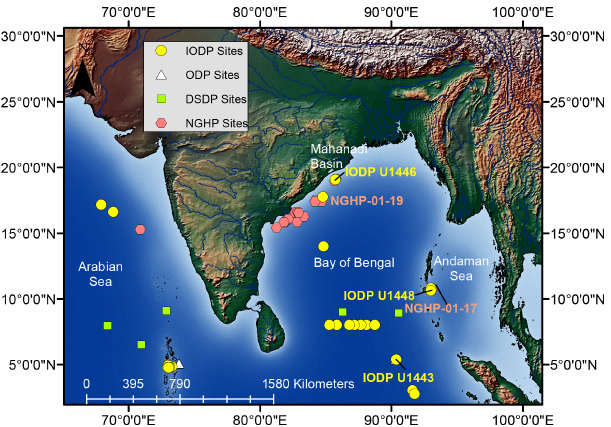
Figure 2. Location map including scientific drilling sites in the northern Indian Ocean. These include expeditions of the Interna- tional Ocean Discovery Program (IODP), Ocean Drilling Program (ODP), Deep Sea Drilling Project (DSDP), and Indian National Gas Hydrate Program (NGHP). All IODP sites within the scale of this map are from the International Ocean Discovery Program phase of drilling, not the Integrated Ocean Drilling Program